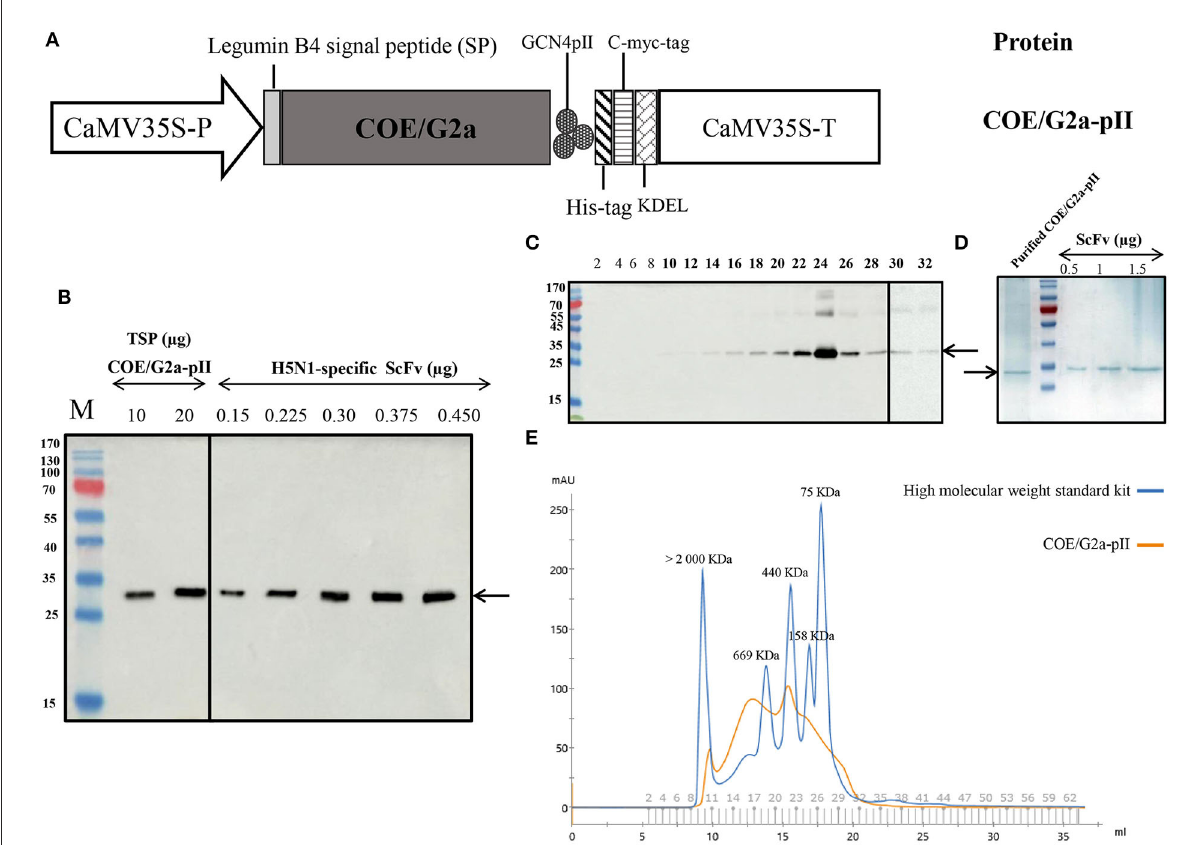
FIGURE1 Production and characterization of COE/G2a-pII protein from plants. (A) Plant expression cassette containing a DNA sequence encoding the highly virulent NAVET/PEDV/PS6/2010 strain (NAVETCO, Vietnam) fused pII motif. CaMV35S-P, cauliflower mosaic virus (CaMV) 35S promoter; pII, GCN4pII motif; KDEL, endoplasmic reticulum retention; CaMV35S-T, CaMV 35S terminator. (B) Detection of COE/G2a protein expressed in N. benthamiana leaves by Western blotting assay. Anti-c-myc monoclonal antibody and HRP conjugated goat anti-mouse IgG were used as primary antibodies and secondary antibodies, respectively. Various amounts of H5N1-specific ScFv antibodies (23) were used to build the standard curve to calculate the accumulation of COE/G2a-pII protein in leaves by ImageQuant TL (Cytiva) after capturing by Amersham TM Imager 680 (Cytiva). (C) Detection of SEC-fractions containing COE/G2a-pII protein by Western blotting assay. (D) Analysis of IMAC-purified COE/G2a-pII protein by Coomassie Blue staining of SDS-PAGE. (E) Characterization of COE/G2a-pII protein by SEC. A standard kit including high molecular weight protein (75–2,000 kDa, GE) was used to estimate the molecular weight of COE/G2a-pII